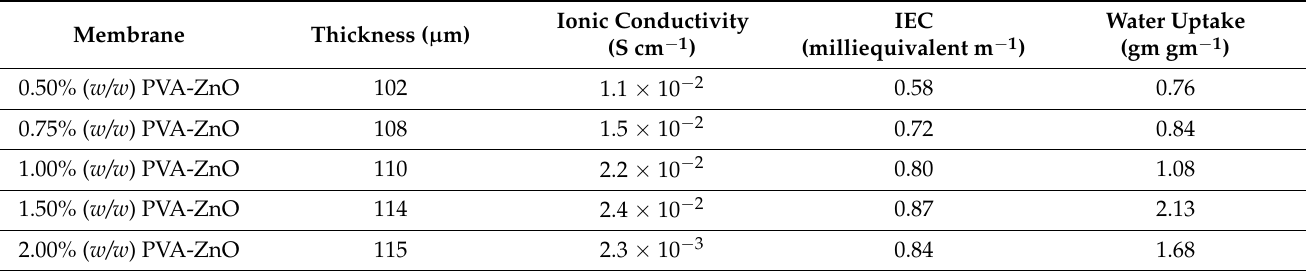
Table 2. Thickness, ionic conductivity, IEC, and water uptake capacity of different ZnO-PVA mem- branes.